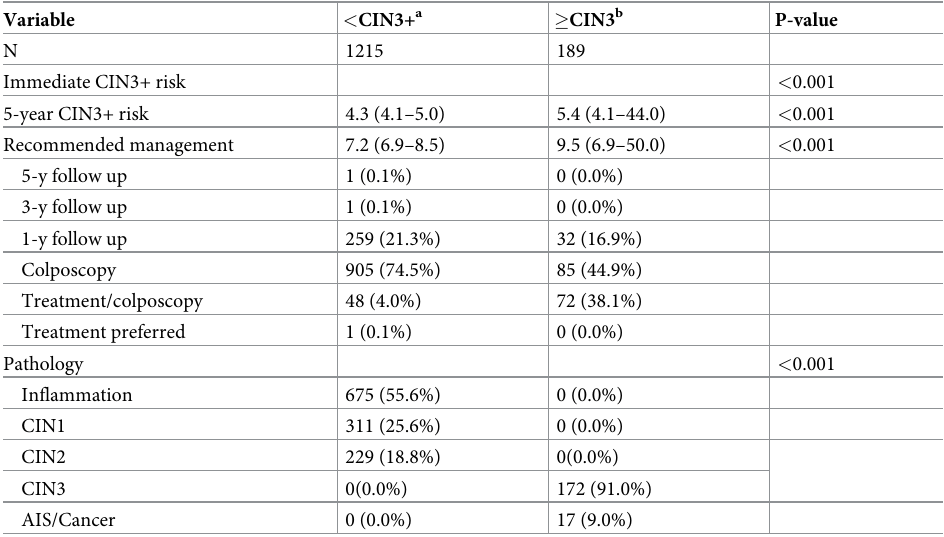
Table 4. Risk estimates and recommended managements.